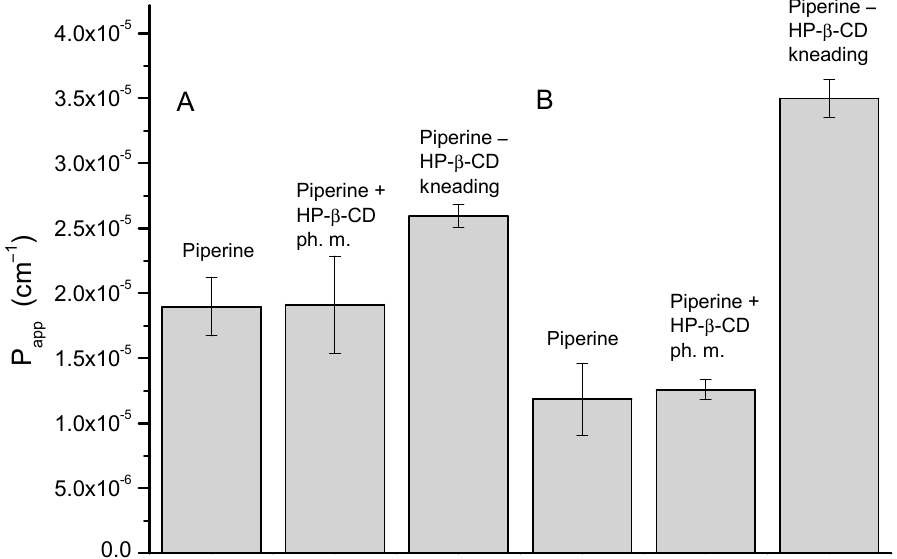
Figure 8. Values of apparent permeability coefficients of piperine determined for gastrointestinal tract (GIT) permeability ( A ) and permeability through the BBB ( B ).